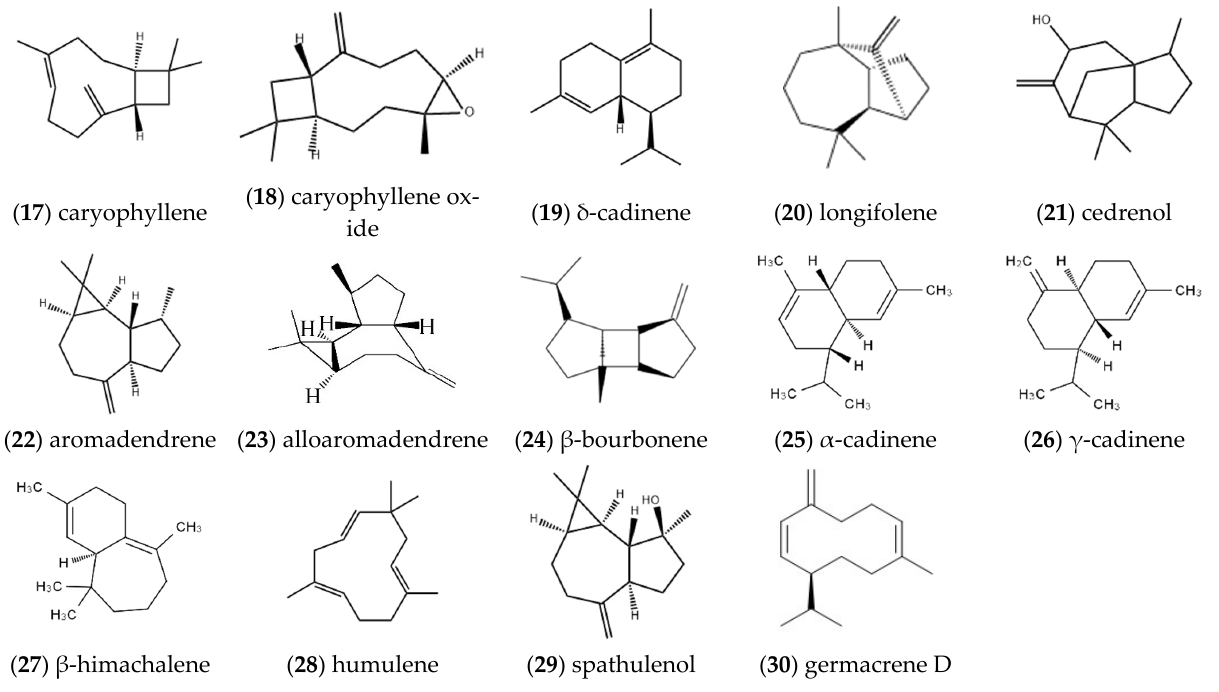
Figure 2. Structures of sesquiterpenes isolated from ST .